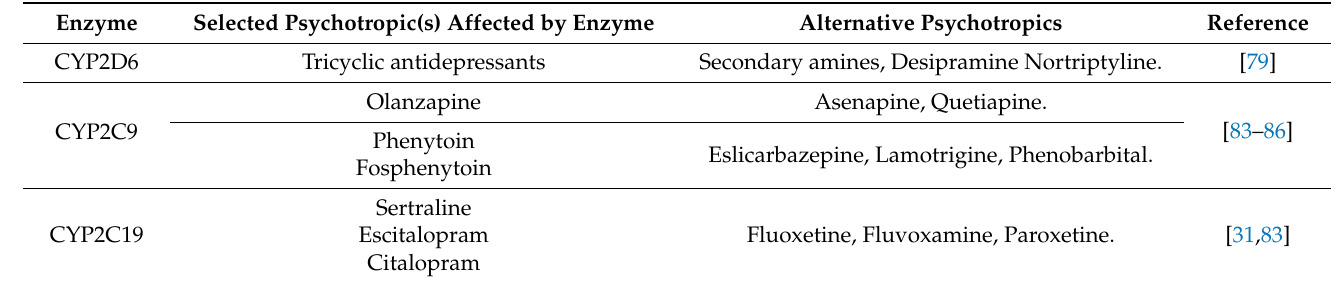
Figure 3. CYP2C19 inter-ethnic star allele frequency (https://www.pharmgkb.org/page/cyp2c19RefMaterials, PharmGKB), accessed on 8 February 2022 [82]. Table 4. Alternative drugs to consider when following CPIC guidelines for selected psychotropics and CYP